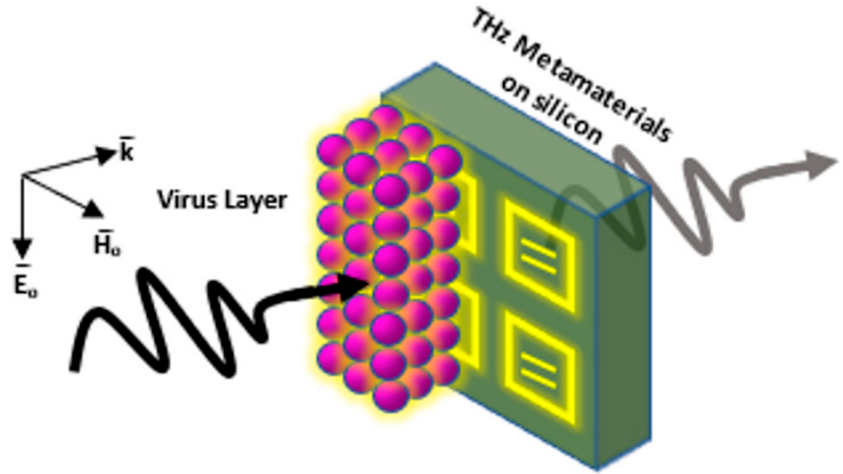
Figure 15. Schematic diagram of nano-gap gold metamaterial based on LC circuit based on dielectric constant virus detection and measurement via THz metamaterials.